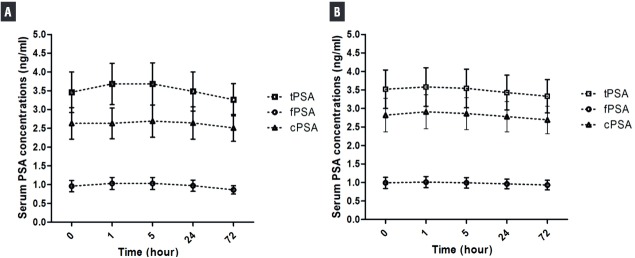
The mean values of PSA forms at baseline (zero), 1st, 5th, 24th and 72th hours’ time points of study (A) and control (B) groups. (Mean±SEM) (tPSA=total prostate-specific antigen; fPSA=free PSA; cPSA=complexed PSA).